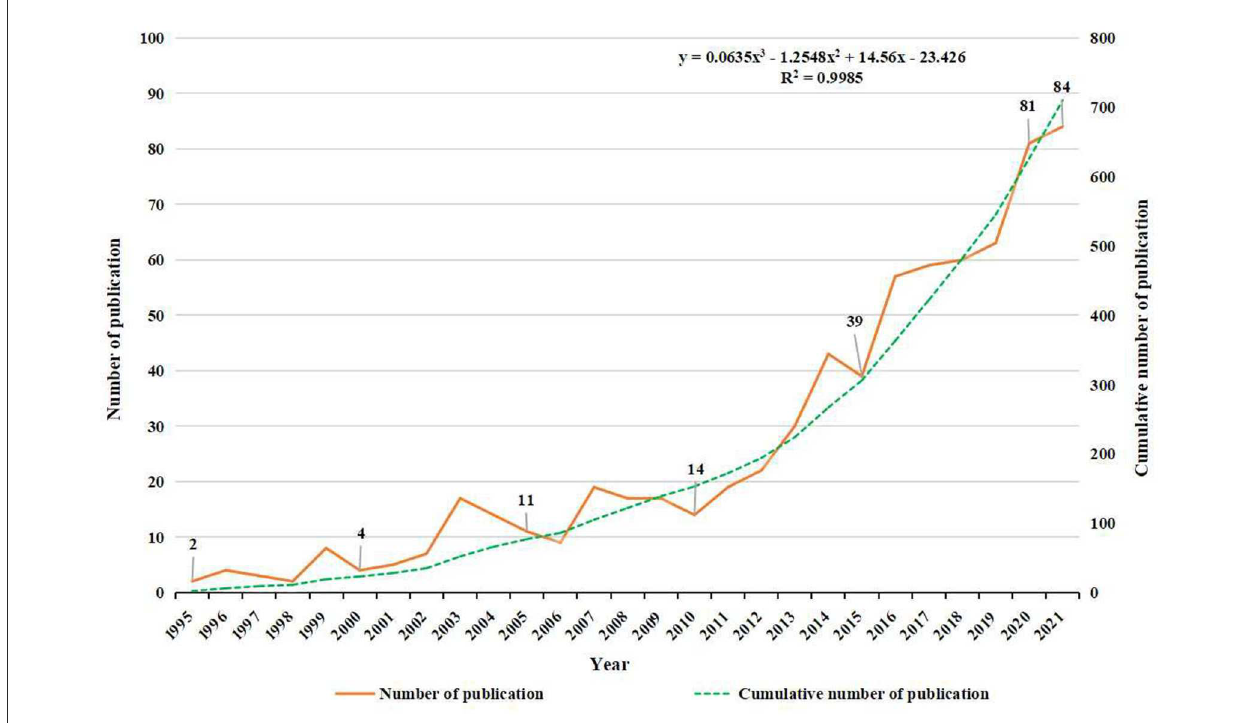
FIGURE2 Trend of publication outputs from 1995 to 2021 on